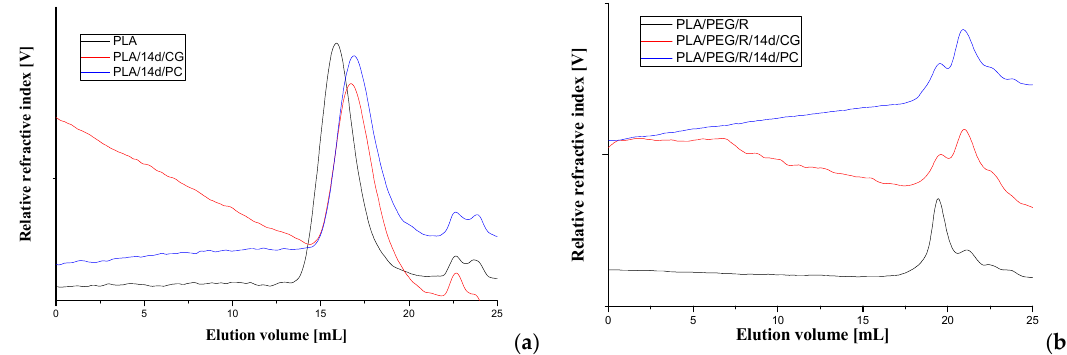
Figure 7. GPC chromatograms of ( a ) PLA and ( b ) PLA / PEG / R samples before and after 14 days exposure to Chaetomium globosum (CG) and Phanerochaete chrysosporium (PC) fungi.